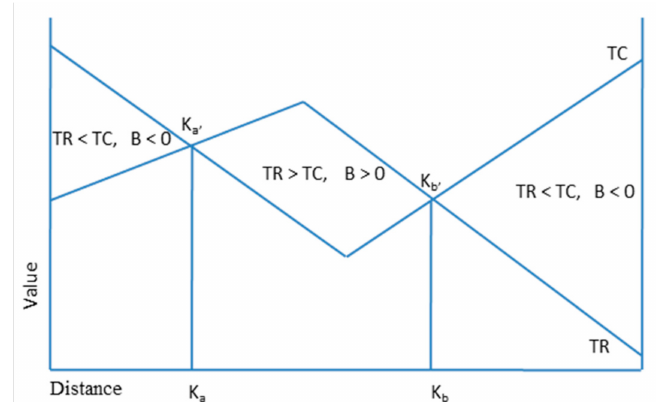
Figure 5. PSBL of external environment of ecological compensation for cultivated land